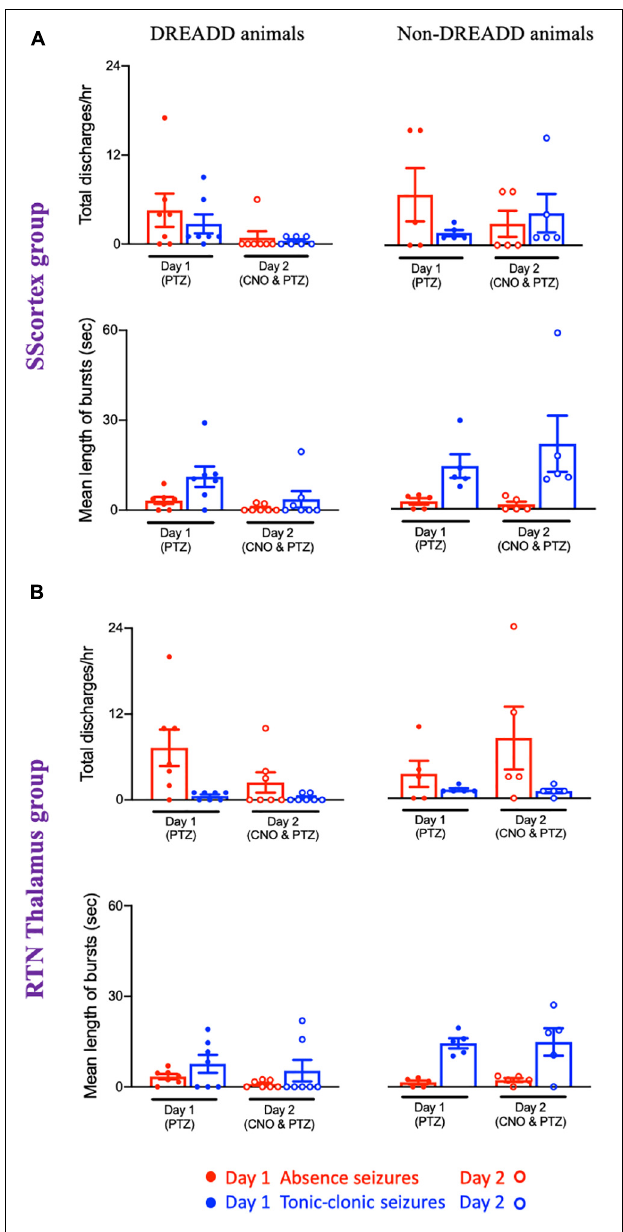
FIGURE 10 | Comparison of mean number of epileptic bursts (discharges/h) and mean length of bursts between PV Cre /Gq-DREADD (DREADD) ( n = 7) and non-DREADD WT ( n = 5) animals of (A) the SScortex and (B) the RTN thalamus group after PTZ treatment on day 1 and CNO and PTZ treatment on day 2. All values represent mean ± SEM. Comparisons were performed using Wilcoxon matched-pairs signed-rank test.